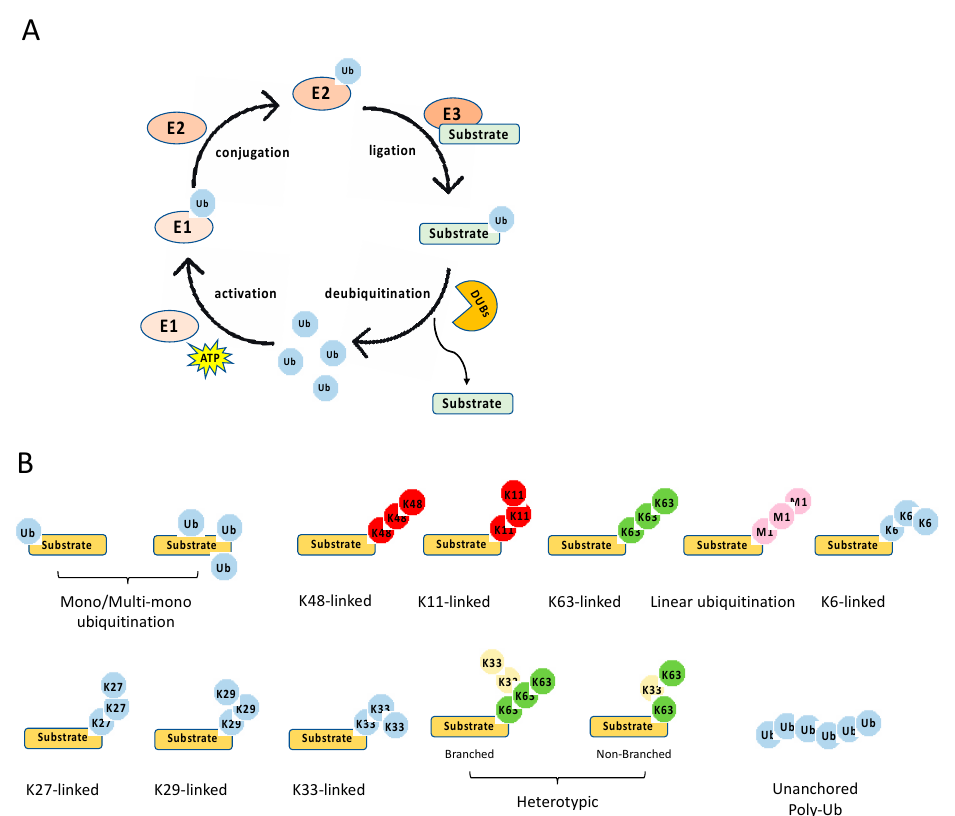
Figure 2. Ubiquitination process and types. ( A ) The multiple steps of the enzymatic process for ubiquitination controlled by E1, E2, E3, and deubiquitinases (DUBs). ( B ) The schematics of various types of ubiquitination.